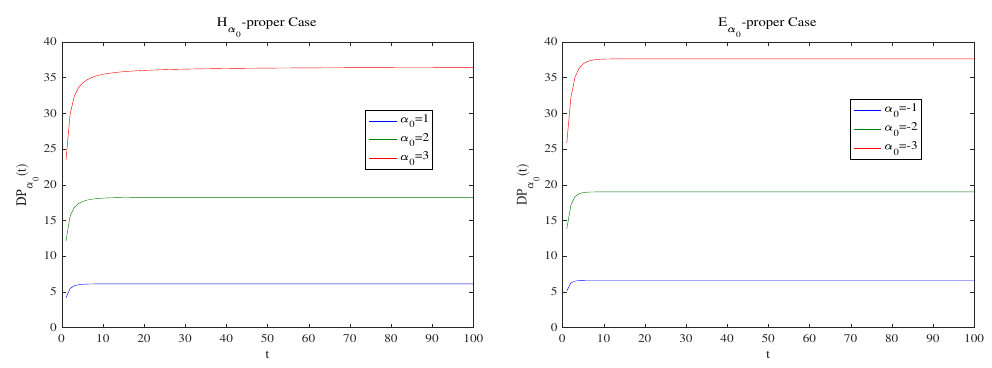
( t ) in scenarios 1 ( left ) and 2 ( right ). Figure 2. DP α 0